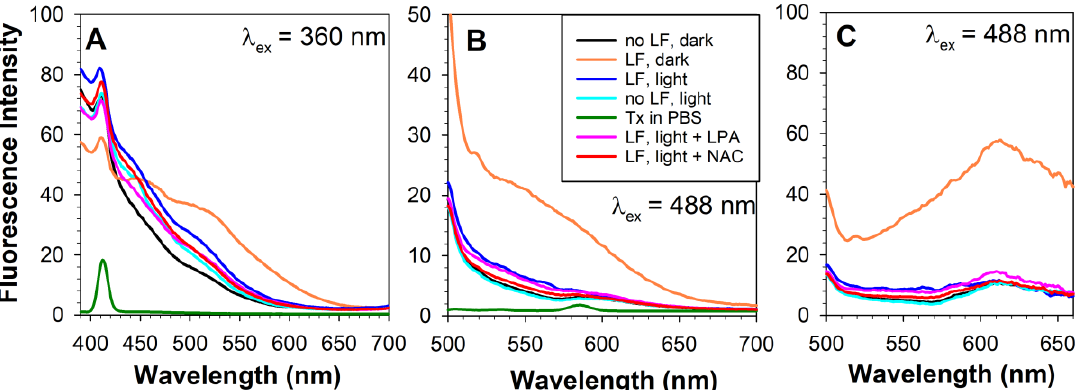
Figure 6. Representative fluorescence emission spectra from ARPE-19 cells solubilized in Triton X-100. Cells were treated as in Figures 3 and 4. Fluorescence was induced by photoexcitation with 360 nm ( A ) or 488 nm ( B ) light. ( C ) Fluorescence emission spectra from ( B ), corrected for the spectral changes in sensitivity of the detector. Confluent cells were supplemented with lipofuscin (LF) or sham-treated (no LF) for 32 days followed by 15 days with 14 daily media changes and 45 min incubations with PBS in dark (dark) or 14 daily media changes and 45 min exposures to 9.76 mJ/cm 2 visible light (light). Cells in selected wells were exposed to light in the presence of 0.1 mM lipoic acid (LPA) or 0.2 mM N-acetyl cysteine (NAC). Green line shows Raman emission peak from solvent, 1% Triton X-100 in PBS (Tx in PBS).